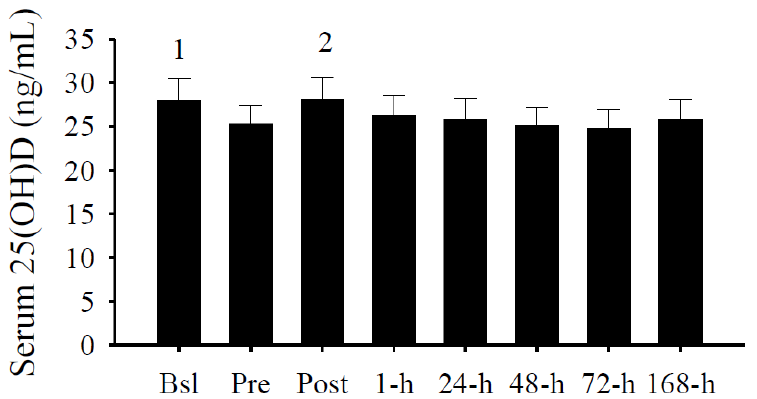
Figure 3. Serum 25(OH)D concentrations (ng/mL). Serum 25(OH)D concentrations were significantly increased at Bsl ( 1 p < 0.05 vs. Pre, 48-h, and 72-h) and Post ( 2 p < 0.05